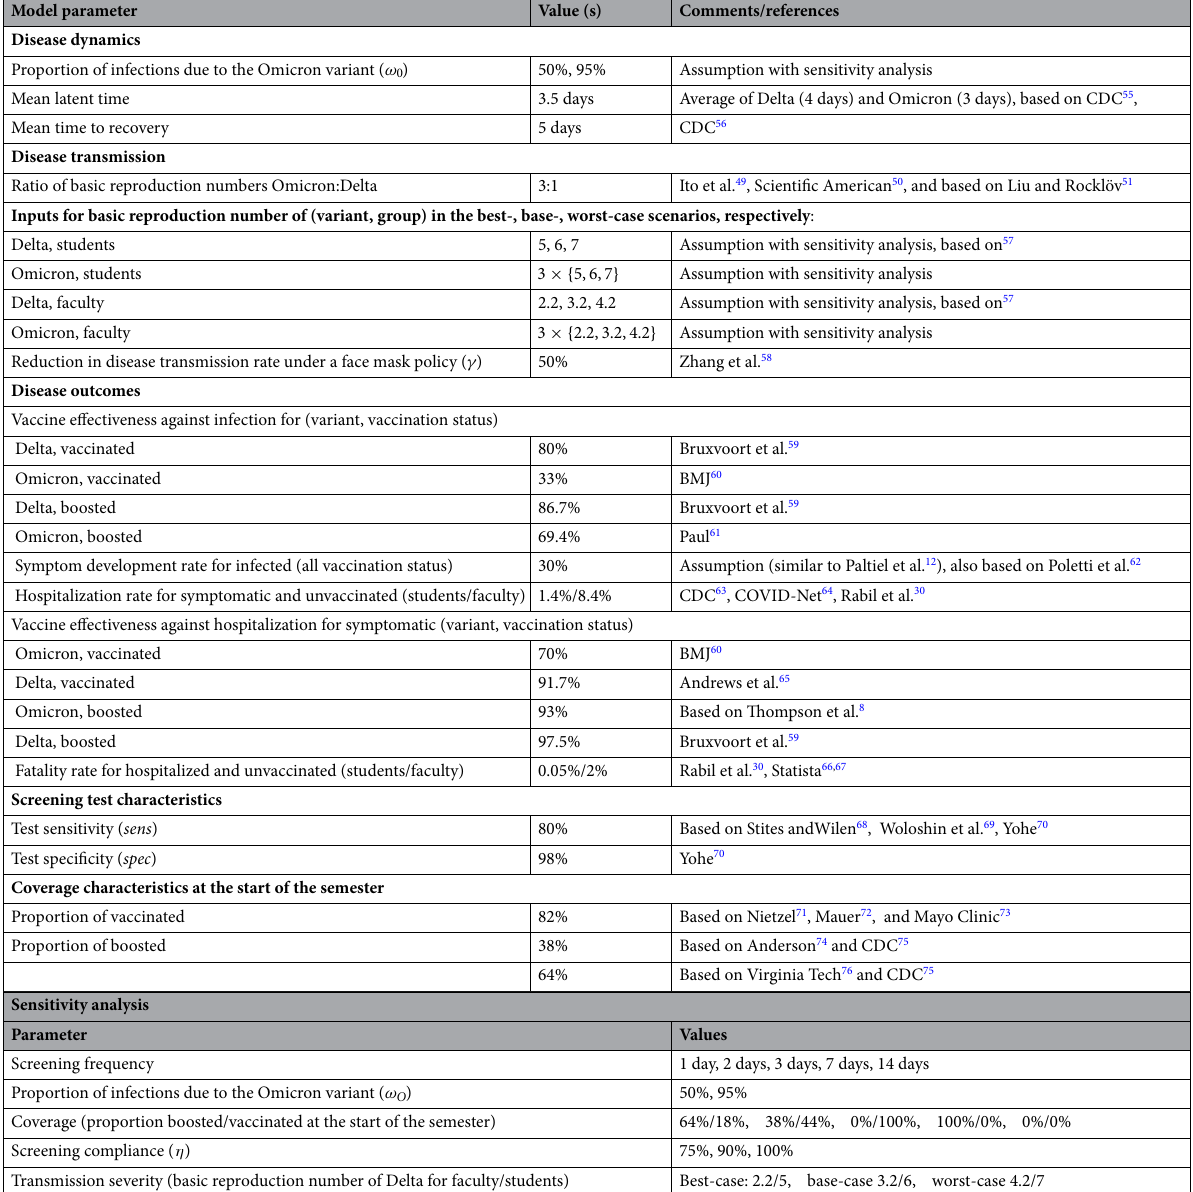
Table 2. Parameter values and ranges for sensitivity